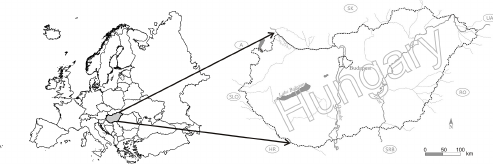
Figure 1. Location of the study